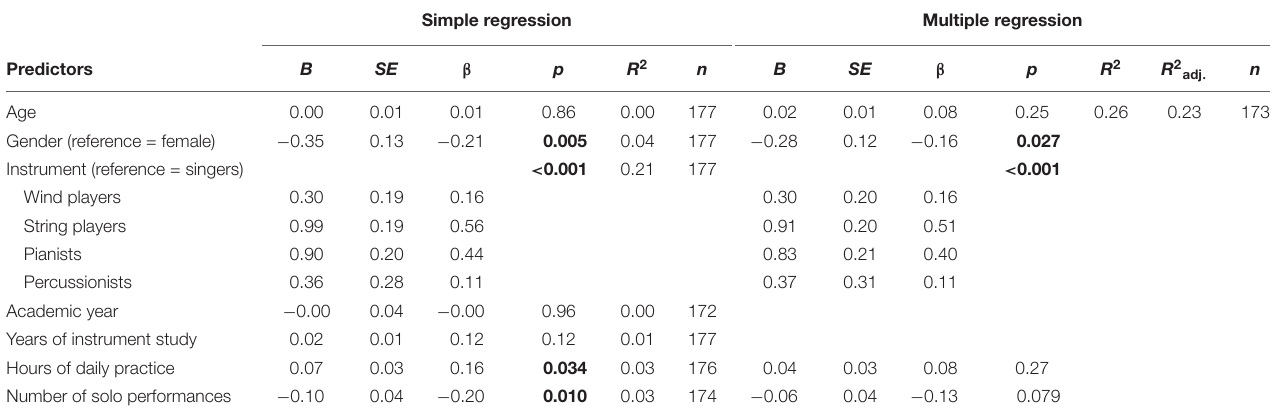
TABLE 7 | Results of the linear regression analyses for hand- and arm-related